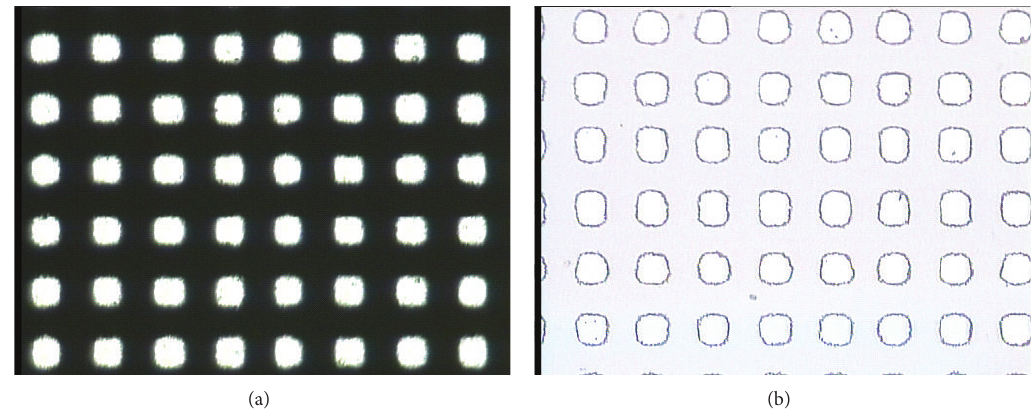
Figure 7: Optical micrograph: (a) photo mask and (b) photoresist pattern after development.